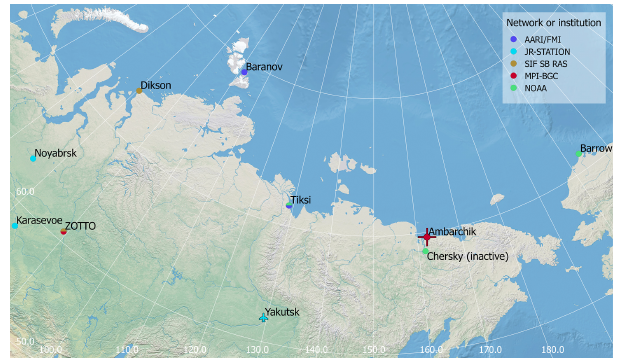
Figure 1. Stations observing atmospheric CO 2 and CH 4 in north- eastern Siberia (including Barrow, Alaska). At all stations but Yakutsk, continuous in situ monitoring takes place. At Yakutsk, flasks are sampled monthly onboard an aircraft. At Tiksi and Bar- row, flasks are sampled by NOAA in addition to the continuous in situ